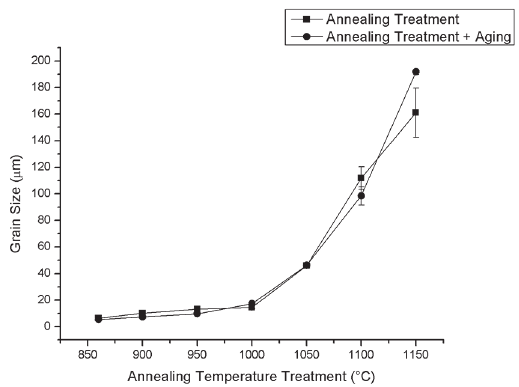
Figure 4: Prior austenite grain size for different annealing temperatures.